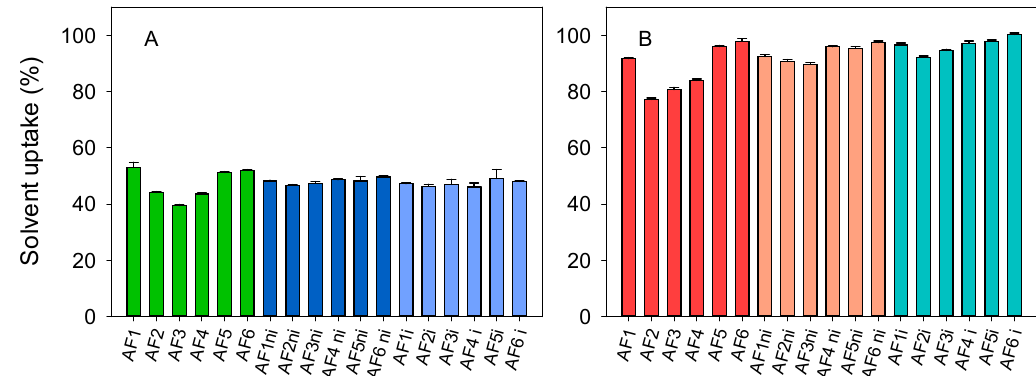
Figure 3. Solvent uptake (%) in ( A ) simulated lachrymal fluid and ( B ) atorvastatin calcium solution (0.04 mg/mL in ethanol:water 20:80 v/v ) for all hydrogels before sterilization. Codes as in Table 1 ( n = 4; mean values and standard devia- tions).